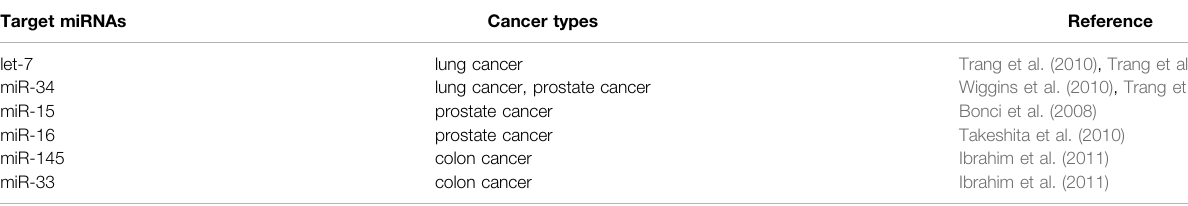
TABLE 2 | Restoring miRNA function by miRNA mimics in cancer.